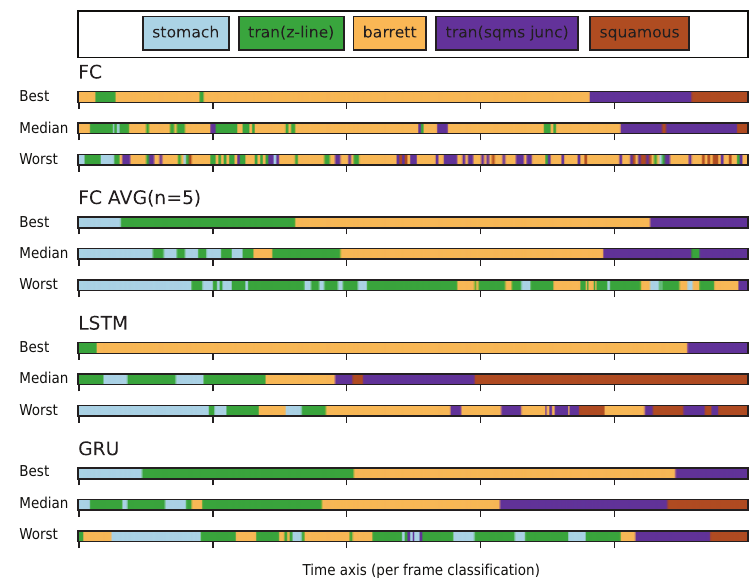
Figure 3. Each bar illustrates the predicted organ labels per frame over a time axis. The figure illustrates the instability of the compared networks architectures at three different performance levels, which are best, median and worst performance for each model respectively. The average domain switch for Fully Connected classifier, is 43.27, Fully Connected Averaged(n=5) 18.49, Long Short-Term Memory classifier 10.81 and Gated Recurrent Unit classifier 11.91